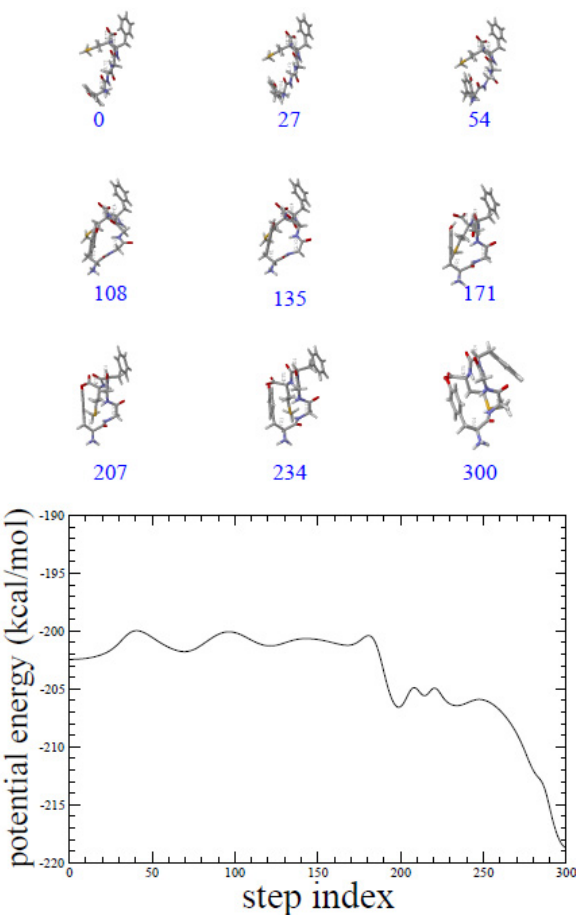
Figure 2. Snapshots of the lowest potential-energy-barrier pathway for met-enkephalin are shown. Potential-energy fluctuation is shown along the ADMD step index. As the index increases, the potential-energies related to the pathway model undergo fluctuation.